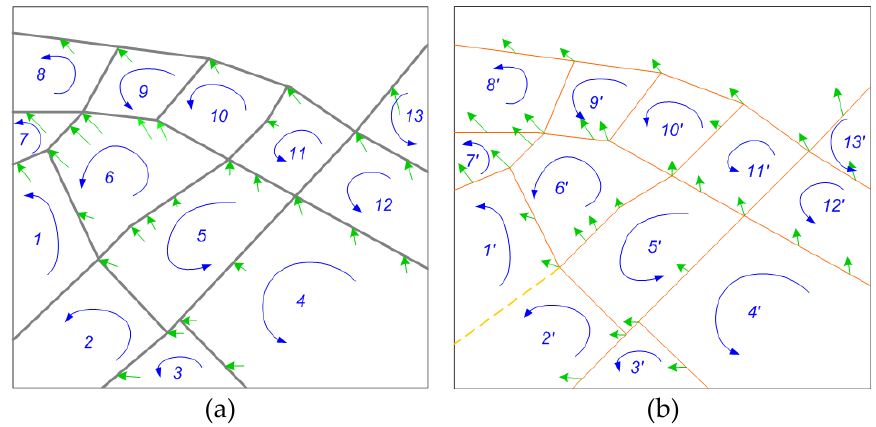
Figure 4. Space partition based on meshes: ( a ) initial meshes based on NAVTEQ; and ( b ) distorted meshes that fit the geometries of ATKIS. Orange solid lines: initial NAVTEQ; grey dash lines: distorted NAVTEQ; green arrows: linkages.